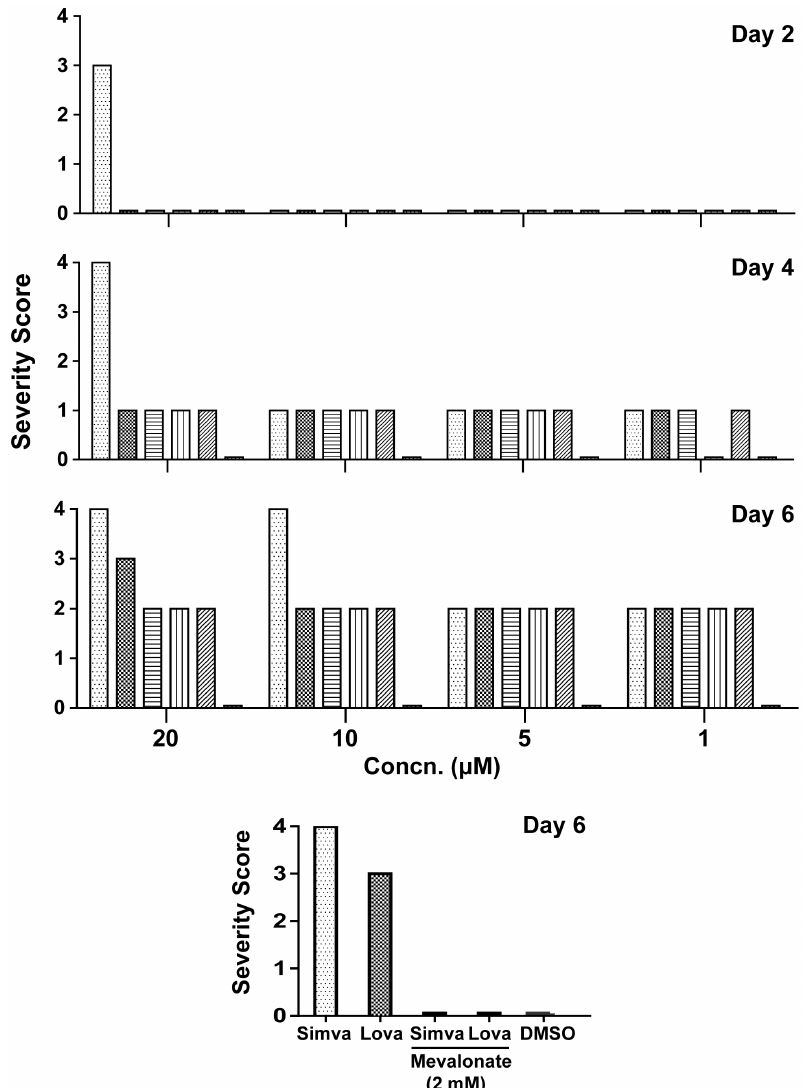
Figure 2. Time- and concentration-dependent effects of six statin drugs on adult S.mansoniinvitro . Adult worms were incubated out to six days in the presence of the concentrations of statins indicated. A severity score was devised based on previously employed phenotype descriptors that record changes in movement, shape, translucence, surface integrity, and the ability of the parasite to adhere to the floor of the culture plate well [35]. Each descriptor was assigned a score of 1, except where damage to the parasite’s surface was evident, in which case the maximum score of 4 was awarded. For each concentration tested, each bar (from left to right) represents simvastatin, lovastatin, atorvastatin, fluvastatin, rosuvastatin and pravastatin. At the bottom, co-incubation with mevalonate (2 mM) for three days prior to the addition of 20 m M simvastatin or lovastatin prevented worm degeneration. Representative data from two independent experiments are shown.